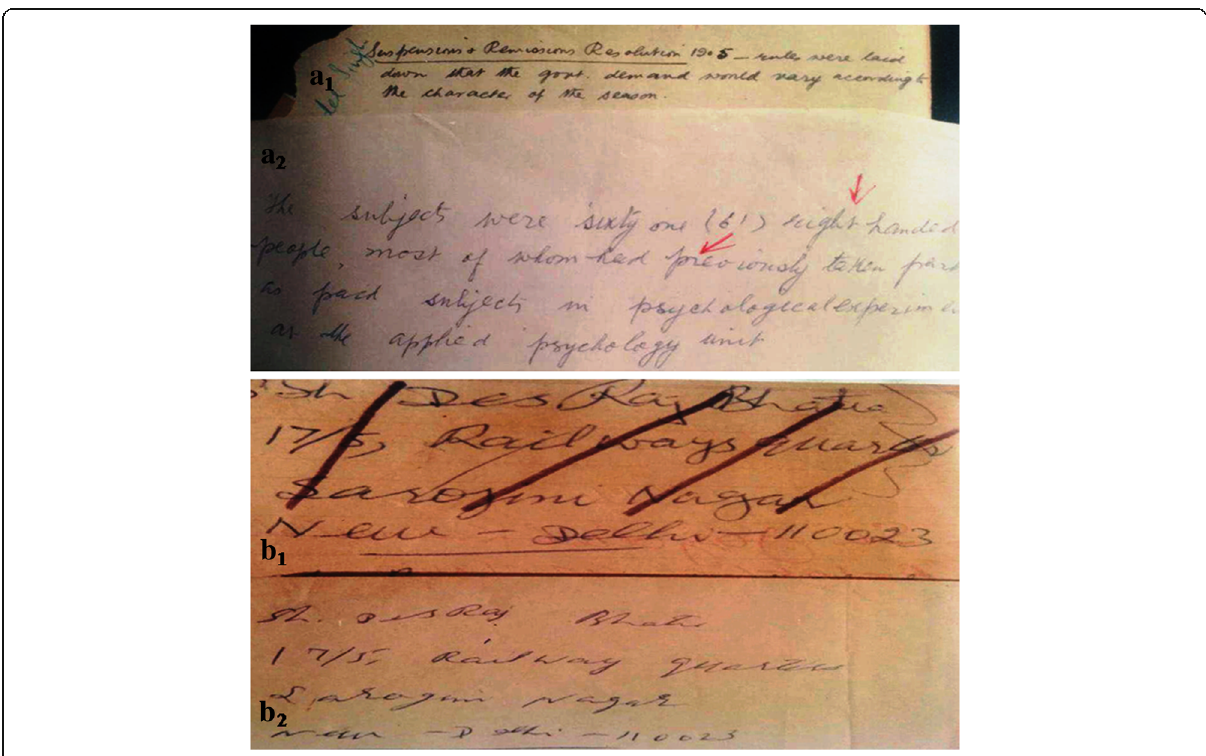
Fig. 6 Size of writing. (a 1 ) Previous handwriting sample of an aged person executed before the age of 60 years. (a 2 ) Handwriting sample of old aged subject revealing marked increase in size as compared to handwriting sample executed during earlier time period (a 1 ). (b 1 ) Previous